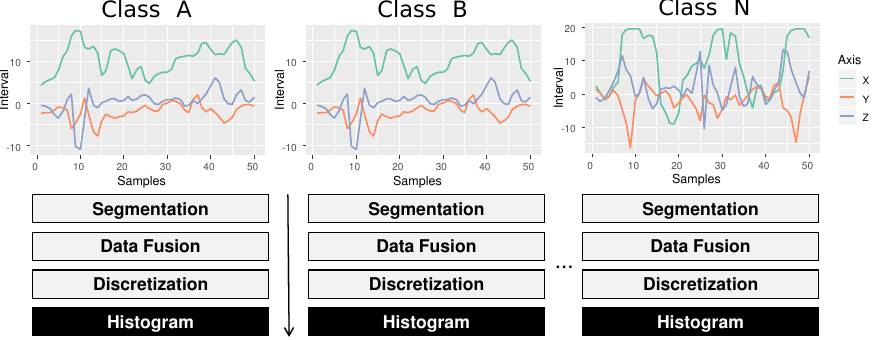
Figure 8. Process of generating the reference histograms for N classes.